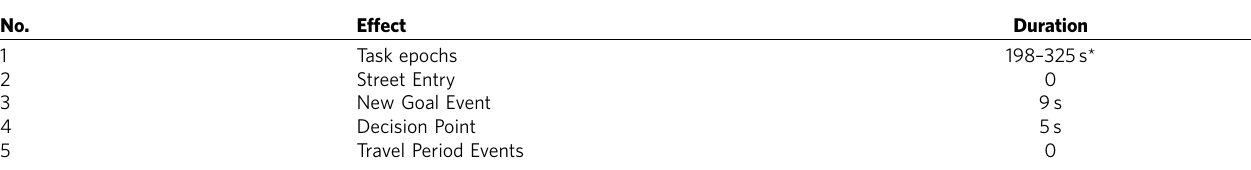
Table 1 | Events/epochs of interest and their duration.